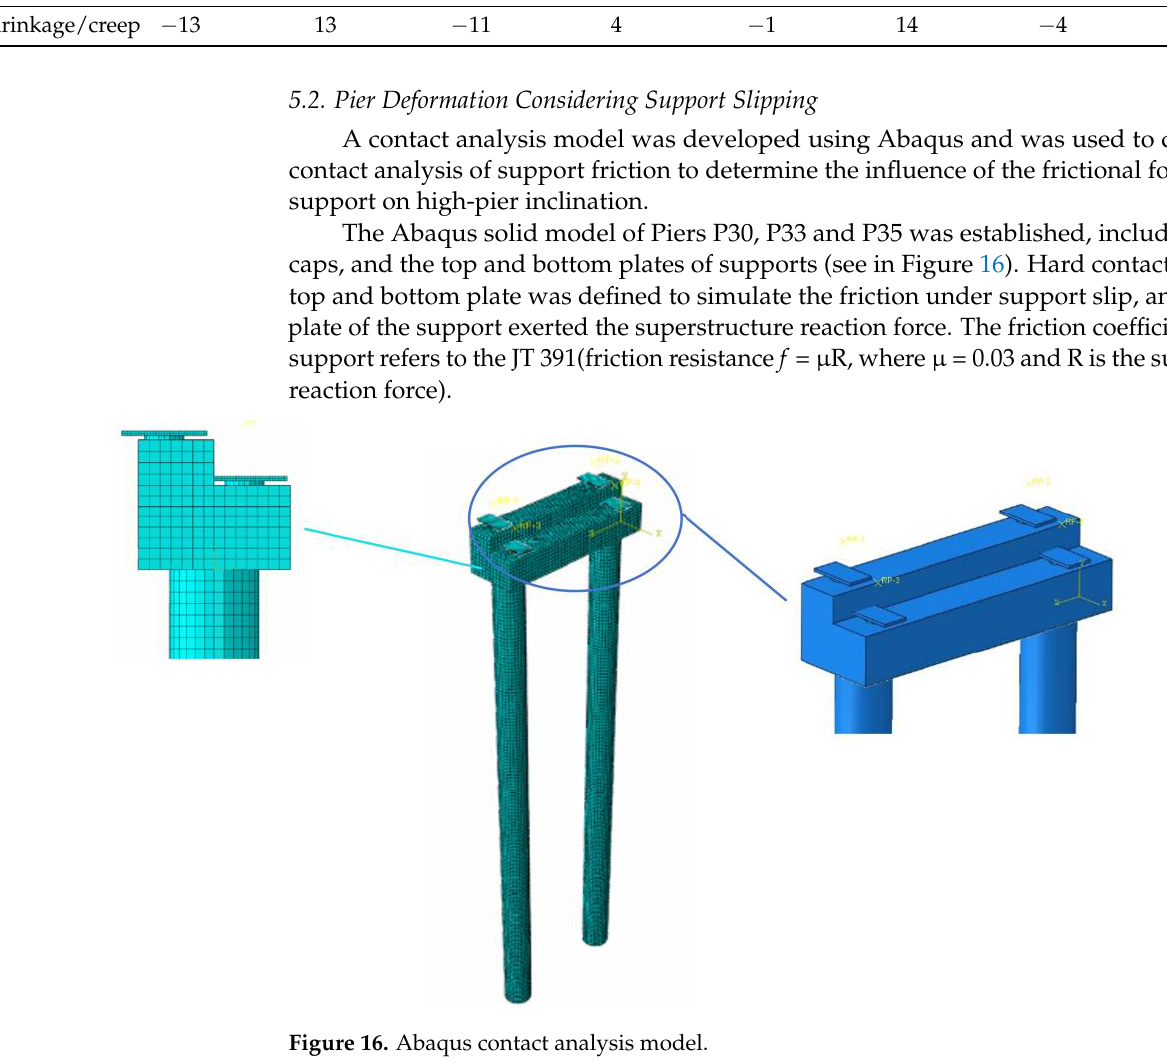
Figure 16. Abaqus contact analysis model.